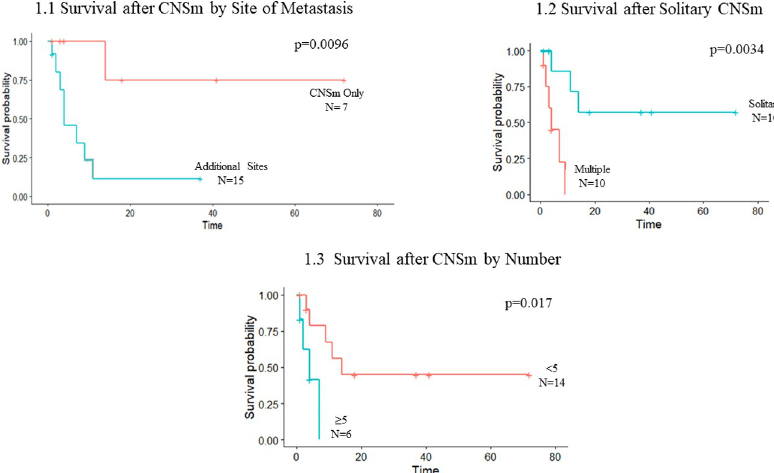
Fig 1. Survival based on central nervous system metastasis characteristics. Survival time displayed in number of months. (1.1) Survival following CNS metastasis with CNS metastasis as only site of recurrence versus those with multiple sites of disease. (1.2) Survival following CNS metastasis diagnosis in patients with solitary CNS metastasis compared to those with multiple CNS metastases. (1.3) Survival following CNS metastasis diagnosis in patients with less than five CNS metastases compared to those with five or more CNS